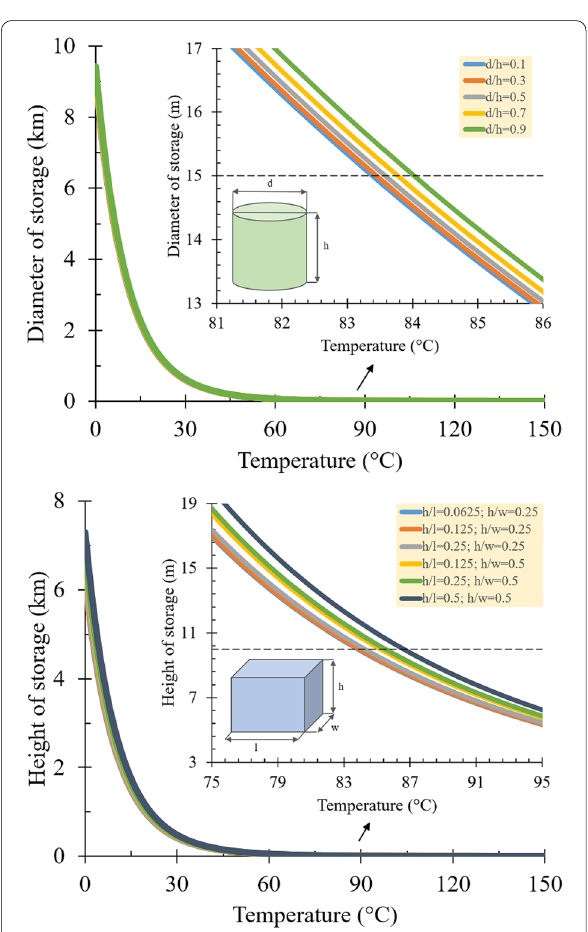
Fig. 7 Relationship between the critical ambient temperature and selected silo dimension for a cylindrical and b rectangular-boxed shapes, including the enlarged curves to show the effect of different dimension